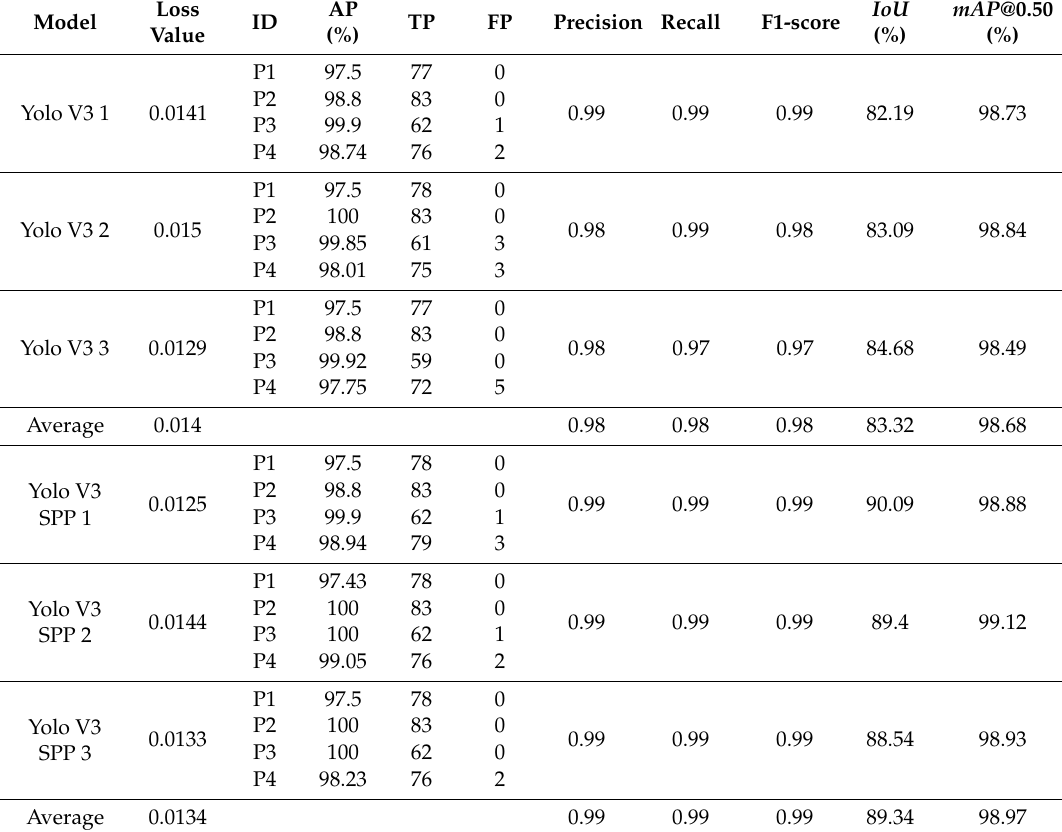
Table 2. Training loss value, mAP , and AP performance for all